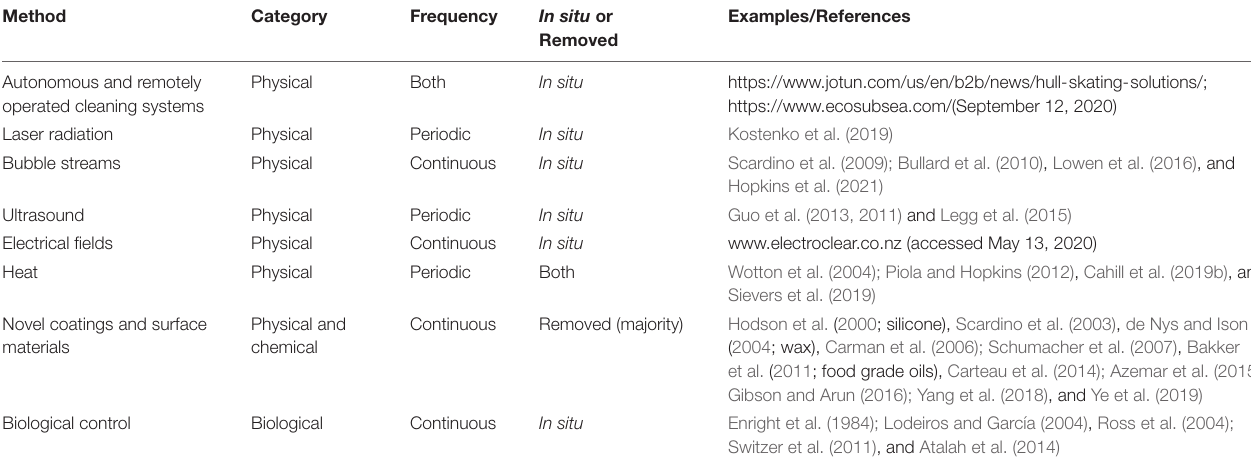
TABLE 2 | Emerging approaches to managing biofouling on submerged marine